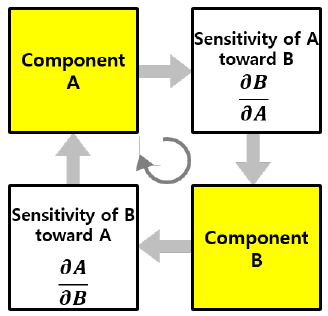
Figure 11. Principle of interaction matrix (modified after [49]).